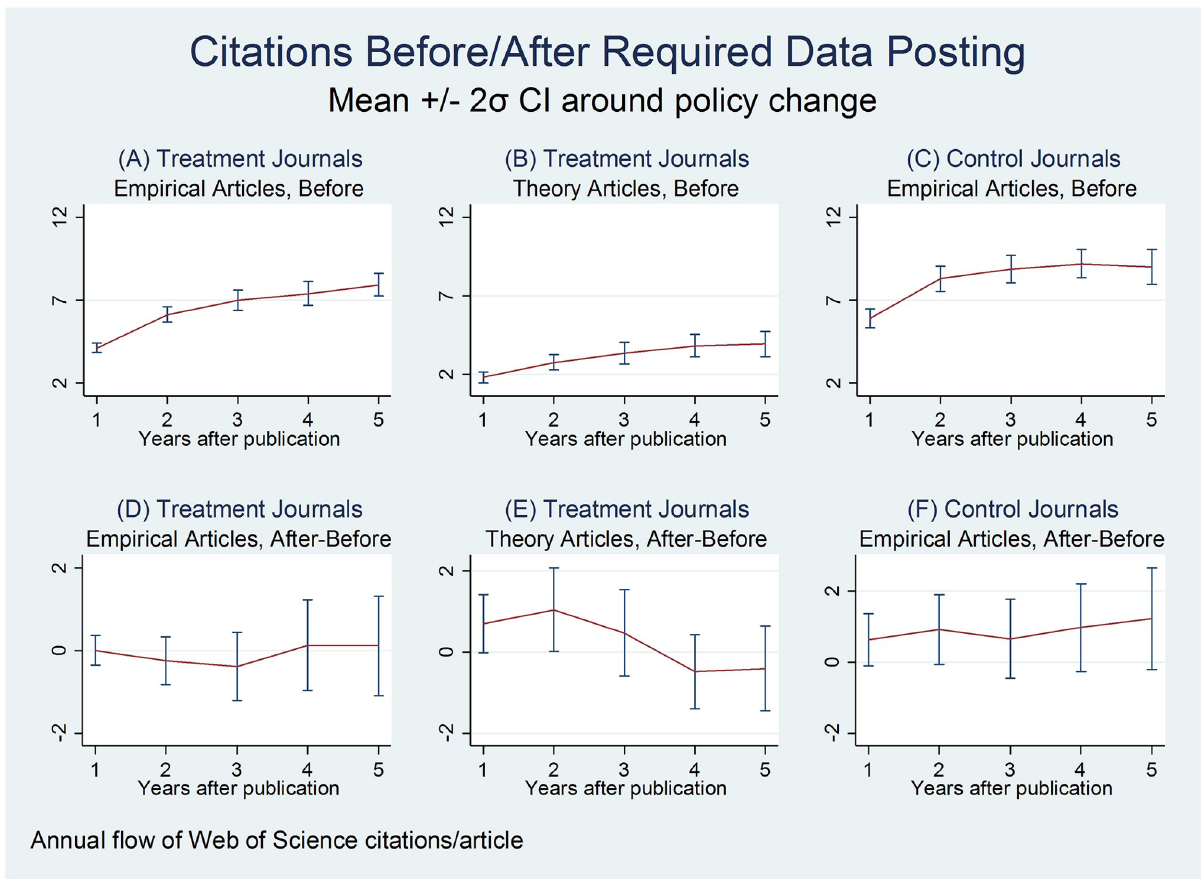
Fig 2. Citations per article appear in the top row, for articles published before treated journals’ adoption of a data-posting policy. The bottom row shows the difference in citations per article following the policy change. Error bars show 95% confidence intervals.